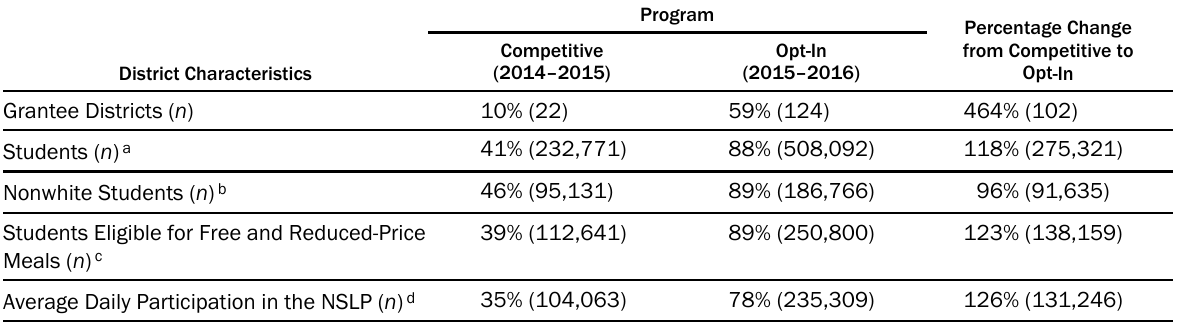
Table 2. Number of Participating Districts and Children in Oregon (Baseline 2014–2015 versus